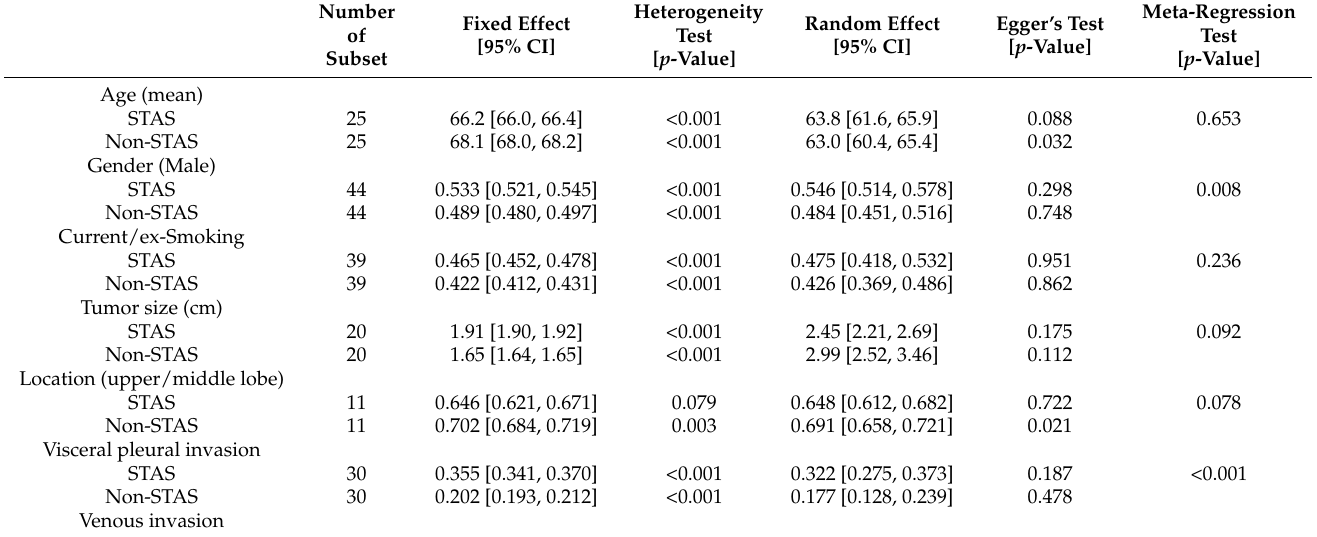
Table 3. Comparisons of clinicopathological parameters between lung cancers with STAS and